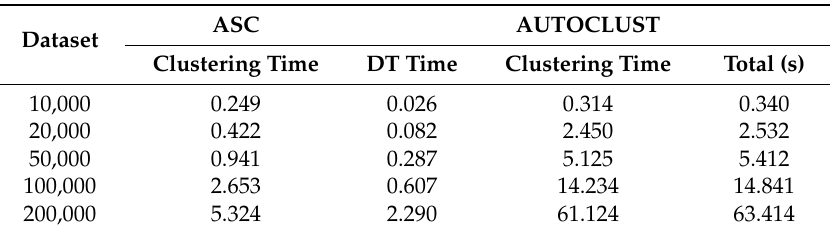
Table 3. CPU time (s) spent by ASC and AUTOCLUST for clustering.